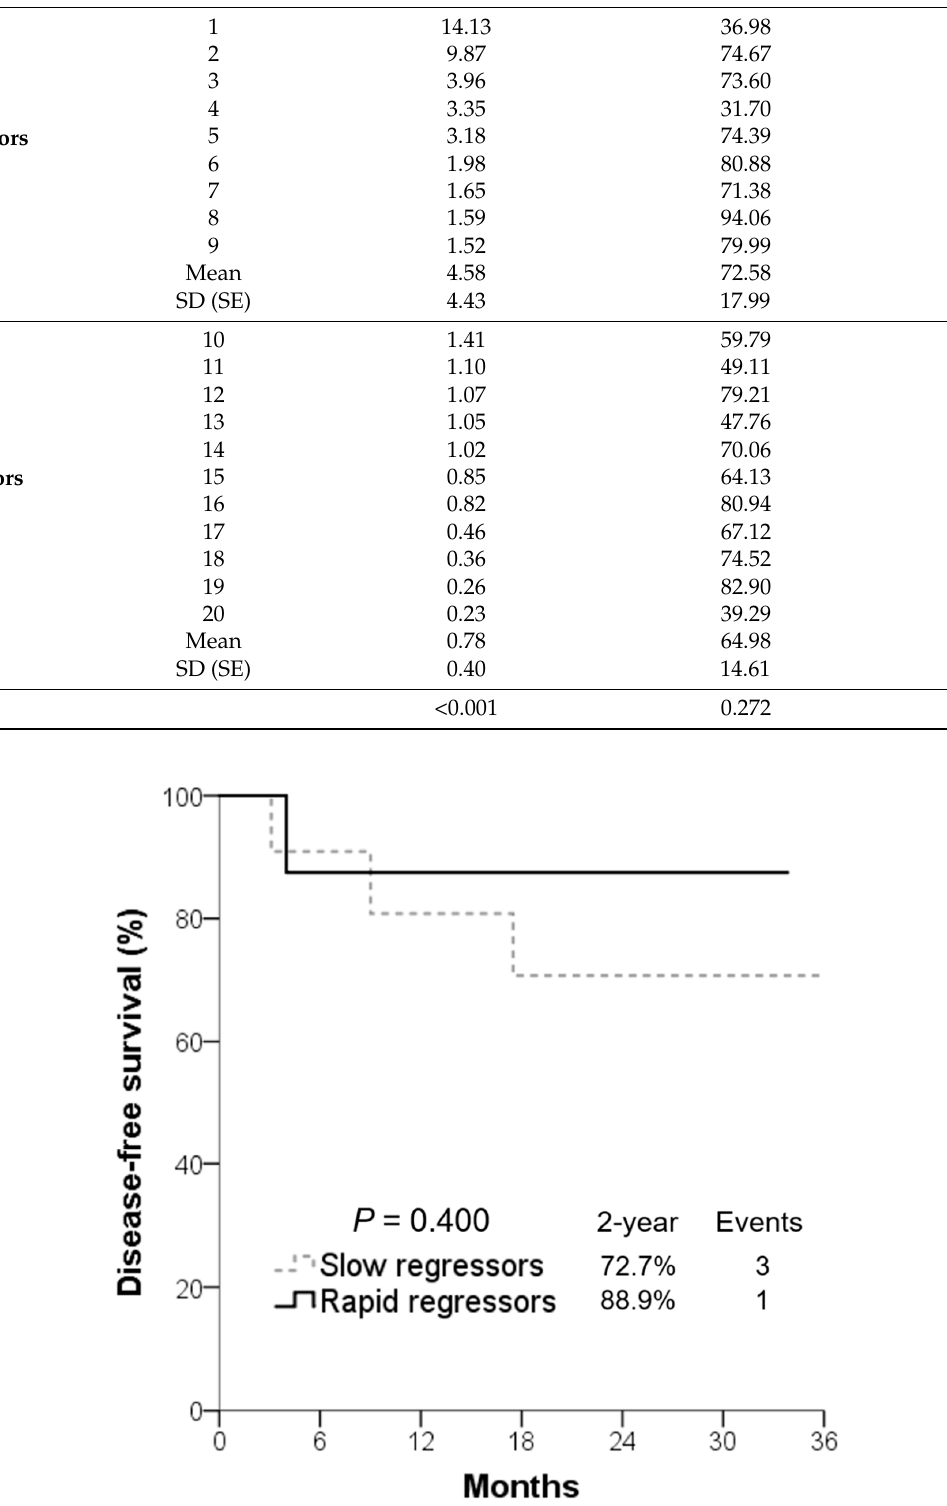
Table 2. Tumor regression velocity (cc) per fraction, tumor regression rate (%), and disease-free survival (DFS) of rapid regressors and slow regressors.